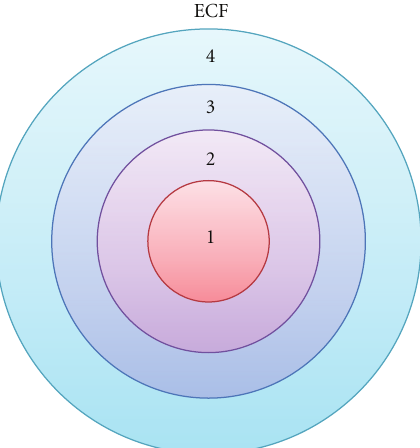
Figure 3: Forward scattering intensity as a function of scattering angle. Full lines: analytic multilayer Mie model. Dashed lines: Numerical FDTD model from Figure 2(a) of Su et al. [18] showing similar behavior. Both perinuclear mitochondria (blue) and near membrane mitochondria cases (red) are